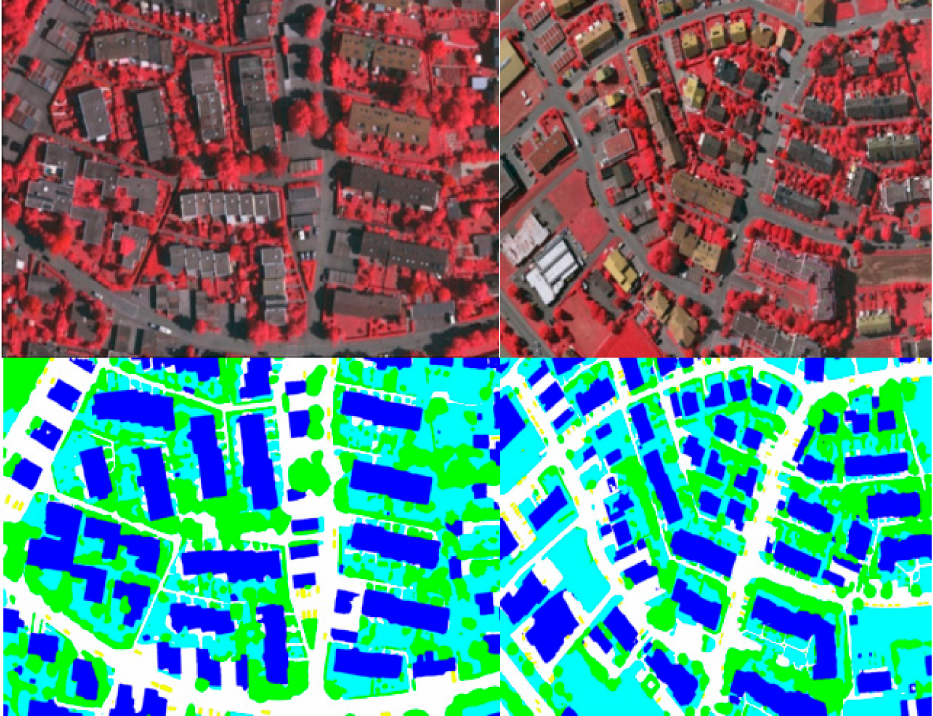
Figure 6. Visualization result of MFNet in a global area that belongs to the Vaihingen